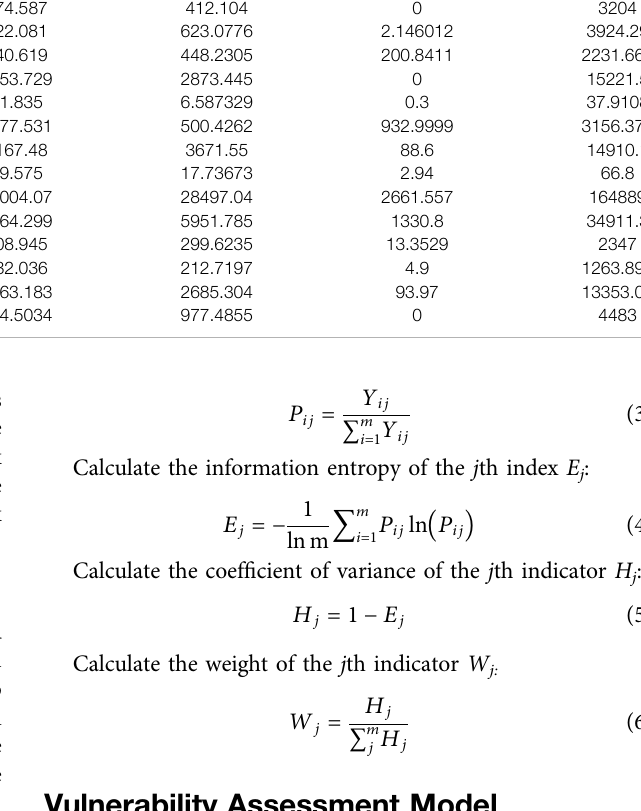
TABLE 2 | Descriptive statistics of the sample. Indicators Obs Mean Std. Dev Min Flood-affected area of